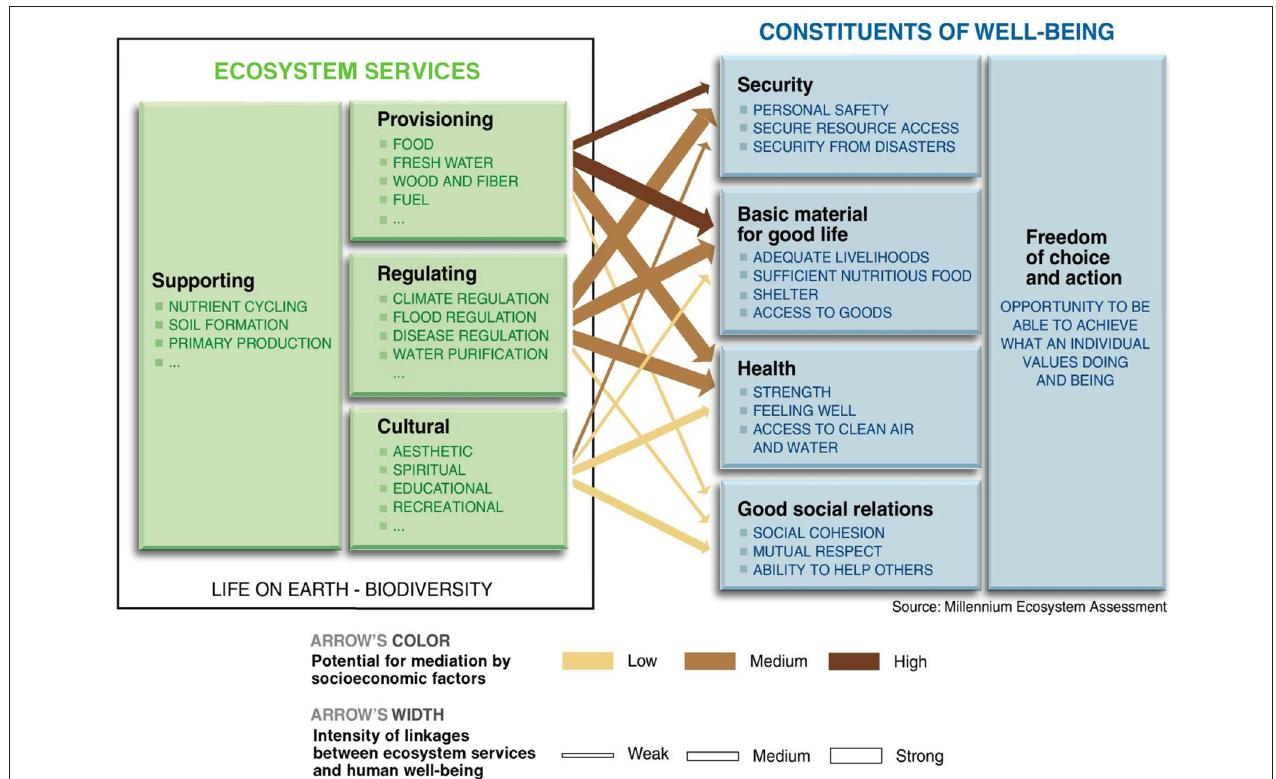
FIGURE 3 | Ecosystem services as defined by the Millenium Ecosystem Assessment (Modified from MEA,